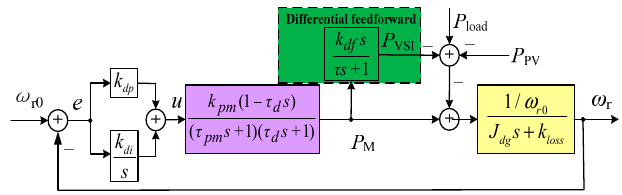
Figure 7. DGS speed control with the differential feedforward of its output current control loop.